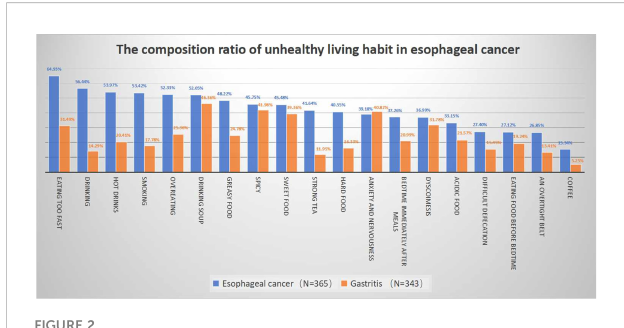
FIGURE 2 The composition ratio of unhealthy living habit in esophageal cancer.